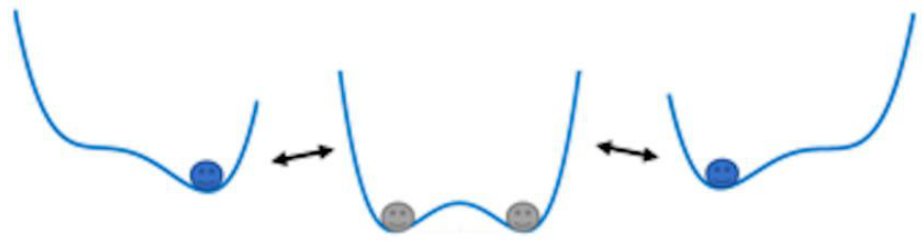
Figure 4. Diagram of stochastic resonance effect of bistable system.